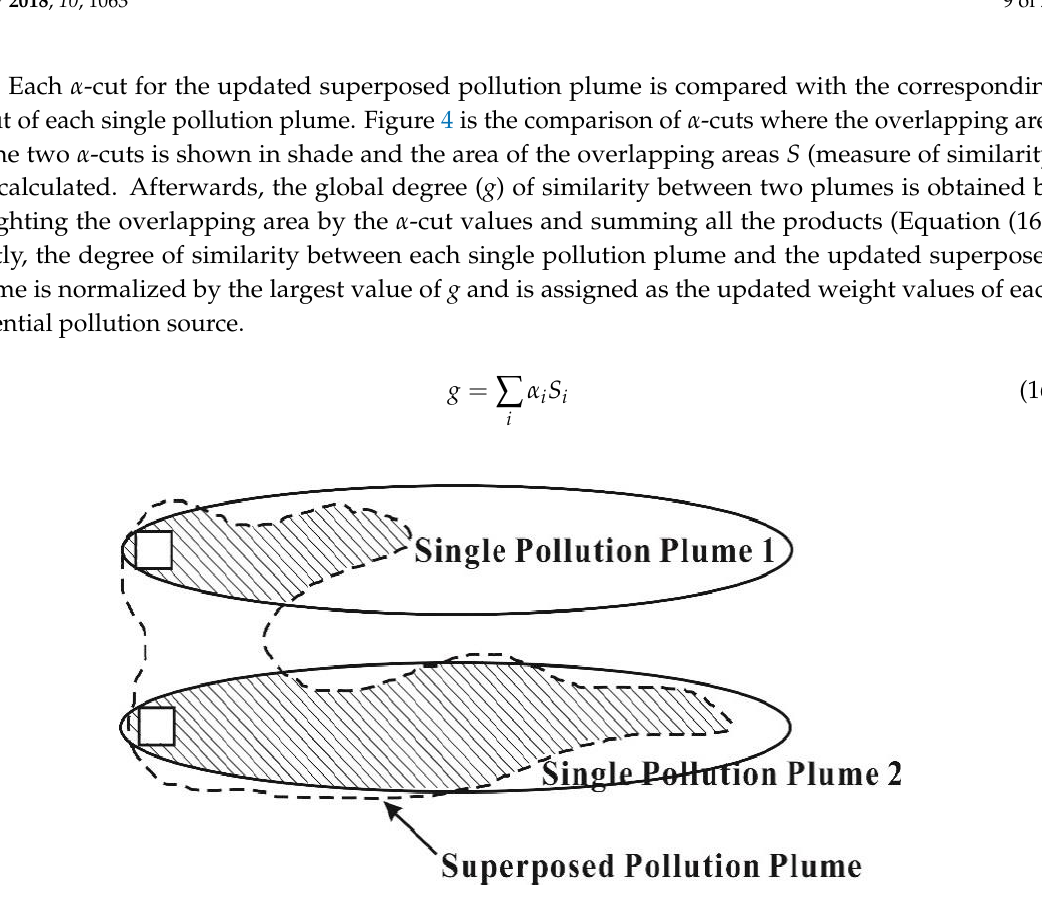
Figure 4. Diagram of morphological comparison of pollution plume.